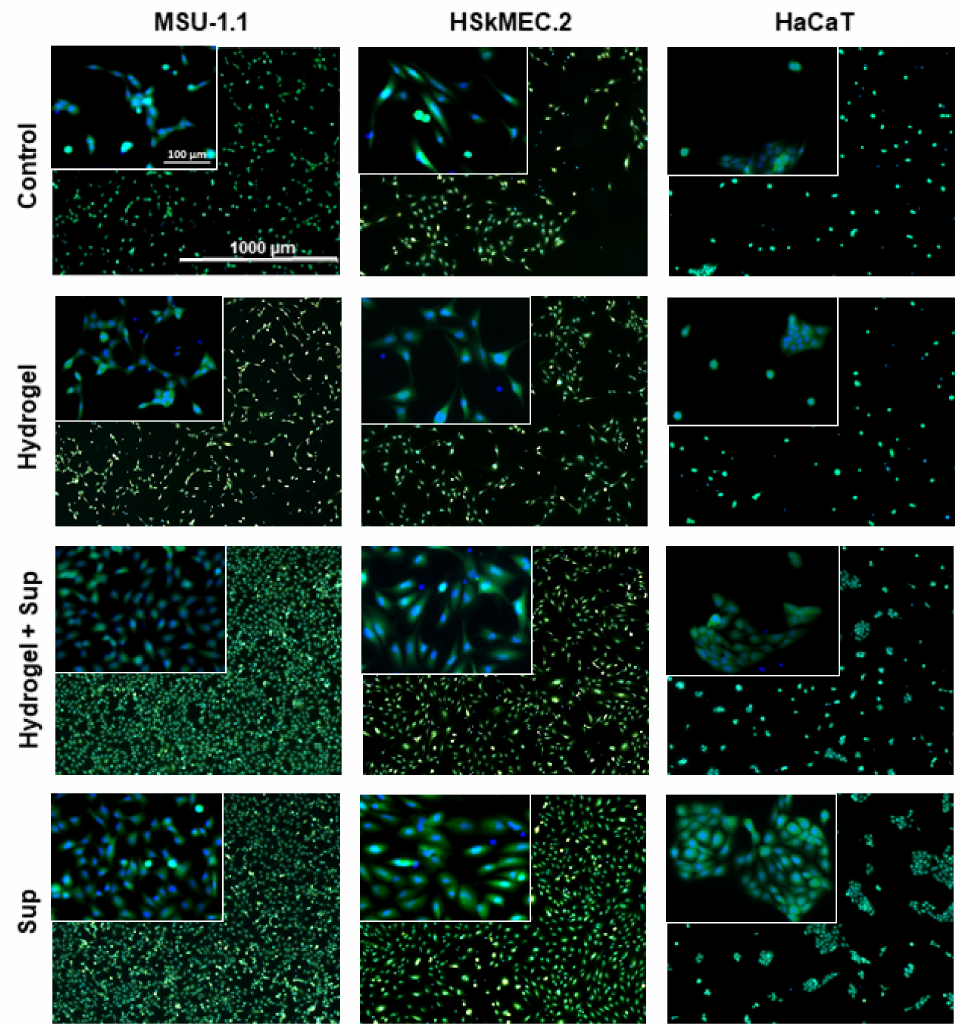
Figure 5. Proliferative activity of skin-derived cells under hydrogel-released HATMSC2 trophic factors measured by Live/Dead assay. Fluorescent images (calcein-green and DAPI-blue) of MSU-1.1 (LH panel), HSkMEC.2 (middle panel) and HaCaT (RH panel) following three-day culture in serum- free medium and 1% O 2 (untreated controls) and cells treated with empty hydrogel, supernatant- loaded hydrogel and 22 µ g HATMSC2 supernatant protein. Inserts on the left top corners are 10 × magnifications of the original